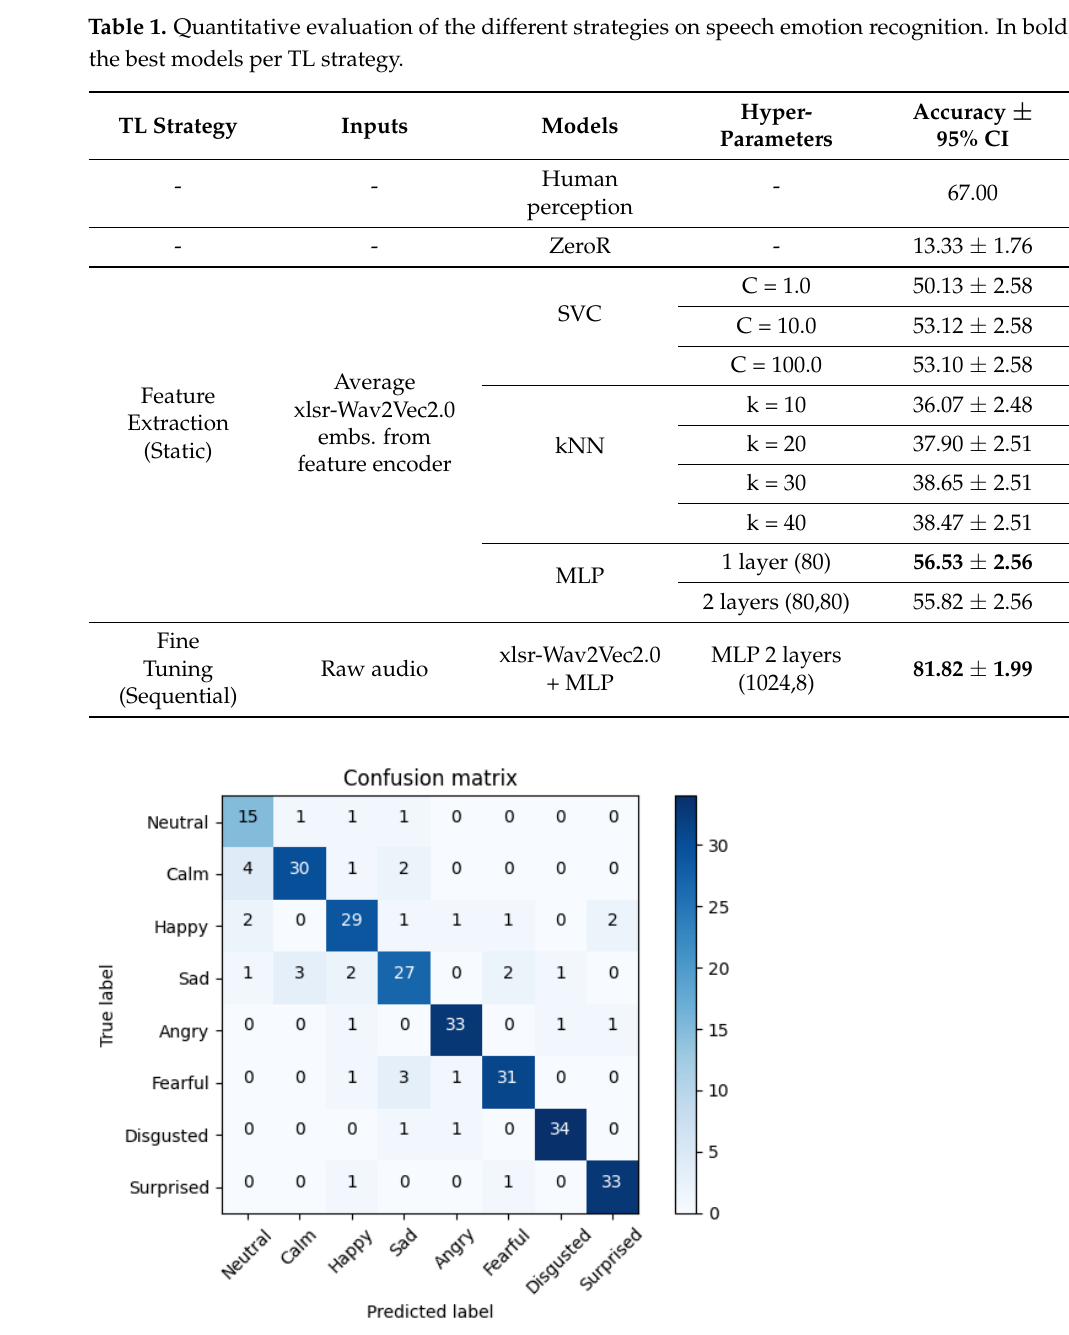
Figure 5. Average confusion matrix of the fine-tuned xlsr-Wav2Vec2.0 experiment with an accuracy of